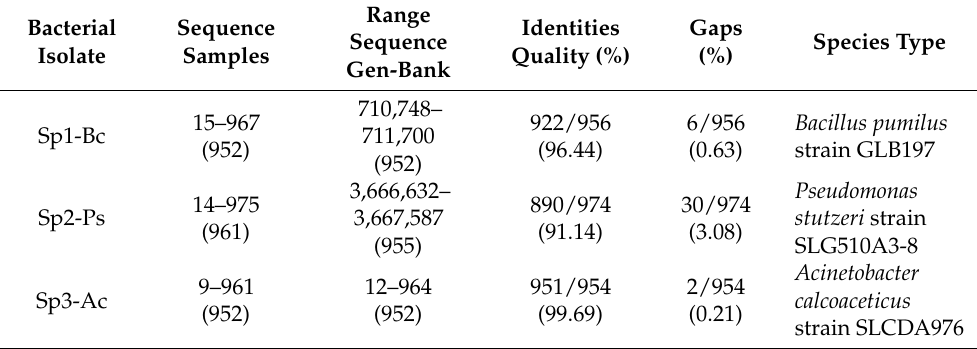
Table 3. Genotypic characteristics of marine sponge symbiont isolates by 16S rRNA gene sequence.